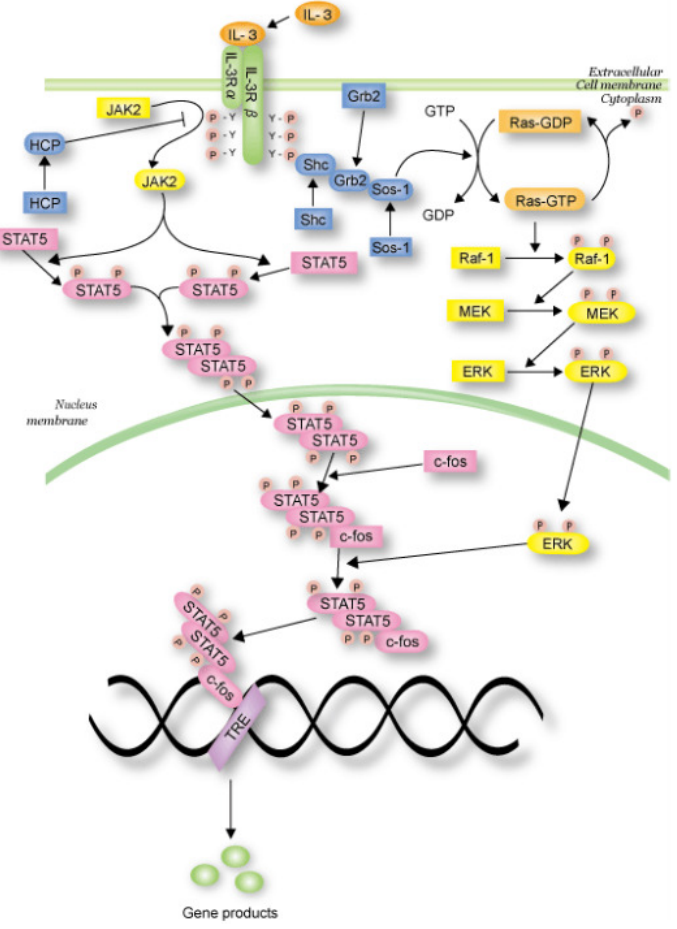
Figure 14. IL-3 signaling pathway